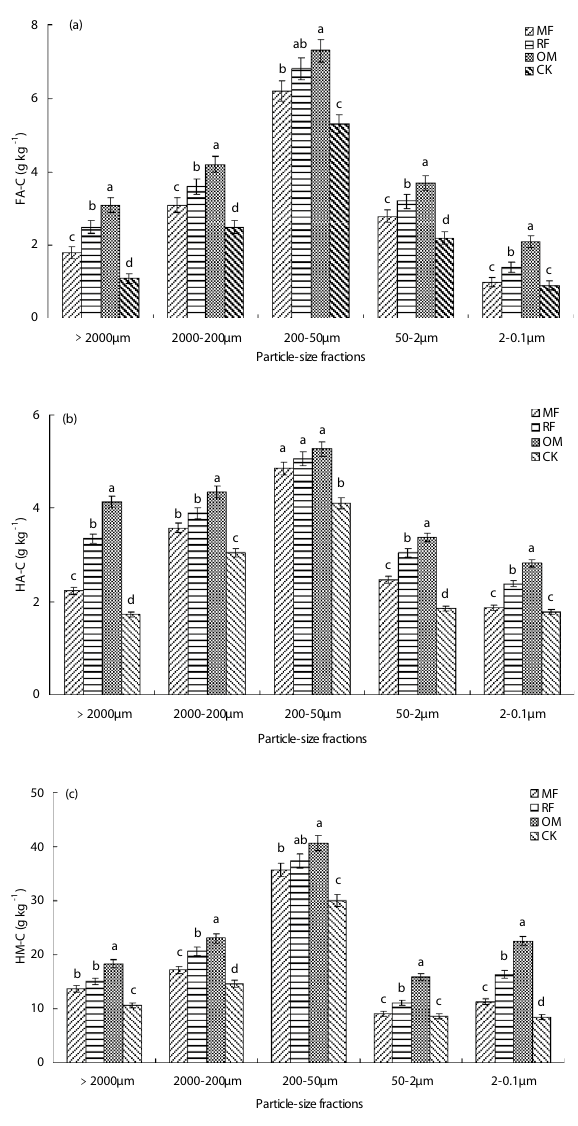
Figure 1. Carbon content of fulvic acid (FA), humic acid (HA) and humin (HM) from different particle-size fractions with different fertilizer treatments. MF chemical fertilizer alone, RF rice straw and chemical fertilizer, OM 30% organic manure and 70% chemical fertilizer, CK without fertilizer input as a control. (a) Carbon content of fulvic acid (FA-C), (b) carbon content of humic acid (HA-C), (c) carbon content of humin (HM-C). Different lowercase letters were indicated significant differences ( p < 0.05) among different fertilizer treatments. Error bars represent standard error of the mean (n =